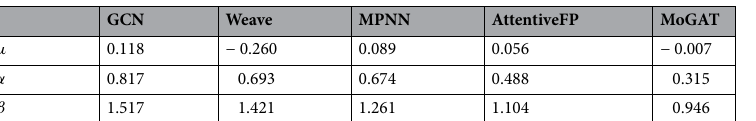
Table 3. Estimated parameters of generalized error distributions corresponding to the proposed and baseline methods. µ , α , and β are location, scale, and shape parameters of the distribution,